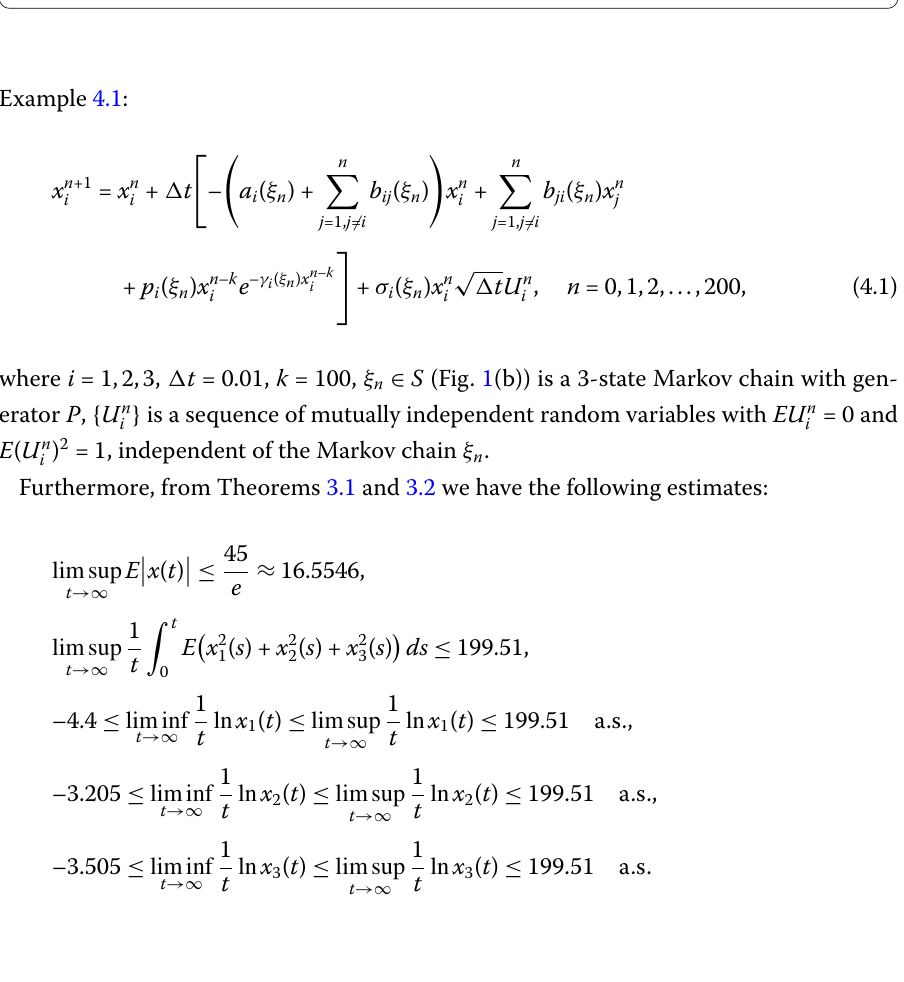
Figure 1 Numerical solutions of Markov switched stochastic Nicholson-type delay system with patch structure (4.1) for initial values ϕ 1 ( s ) = 1.1, ϕ 2 ( s ) = 1, ϕ 3 ( s ) = 0.9, s ∈